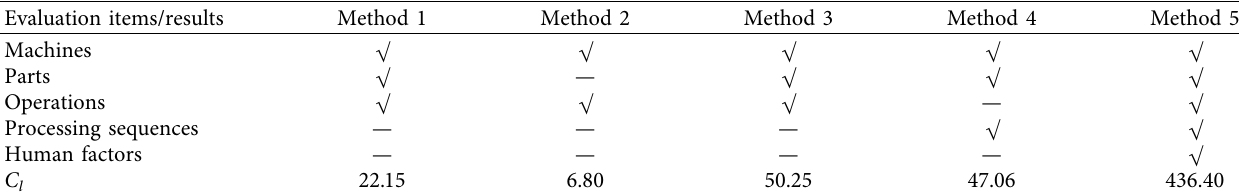
Table 13: Comparison of five production chain complexity evaluation